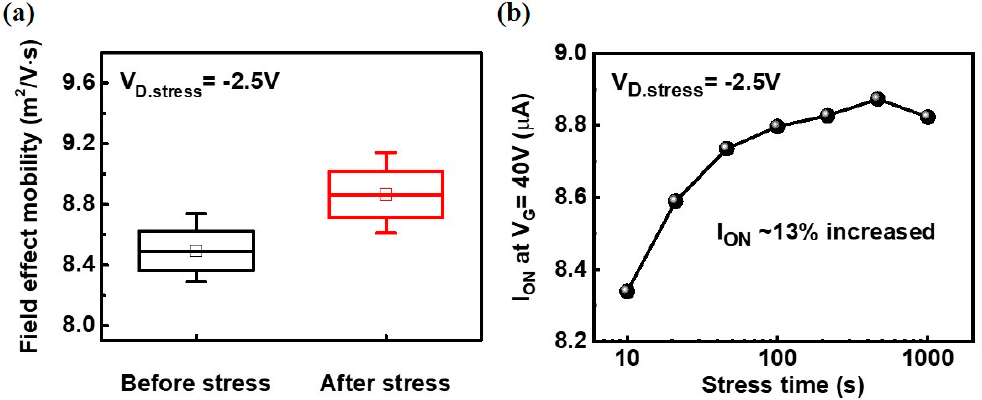
Figure 5. Increase of the field-effect mobility ( a ) and on-current ( b ) after negative drain bias stress with reducing “hump” phenomenon. The field-effect mobility increased from ~8.5 cm 2 V − 1 ∙ s − 1 to ~8.9 cm 2 V − 1 ∙ s − 1 and on-current was increased by approximately 13% after negative drain bias stress by the trap-induced Schottky barrier lowering.